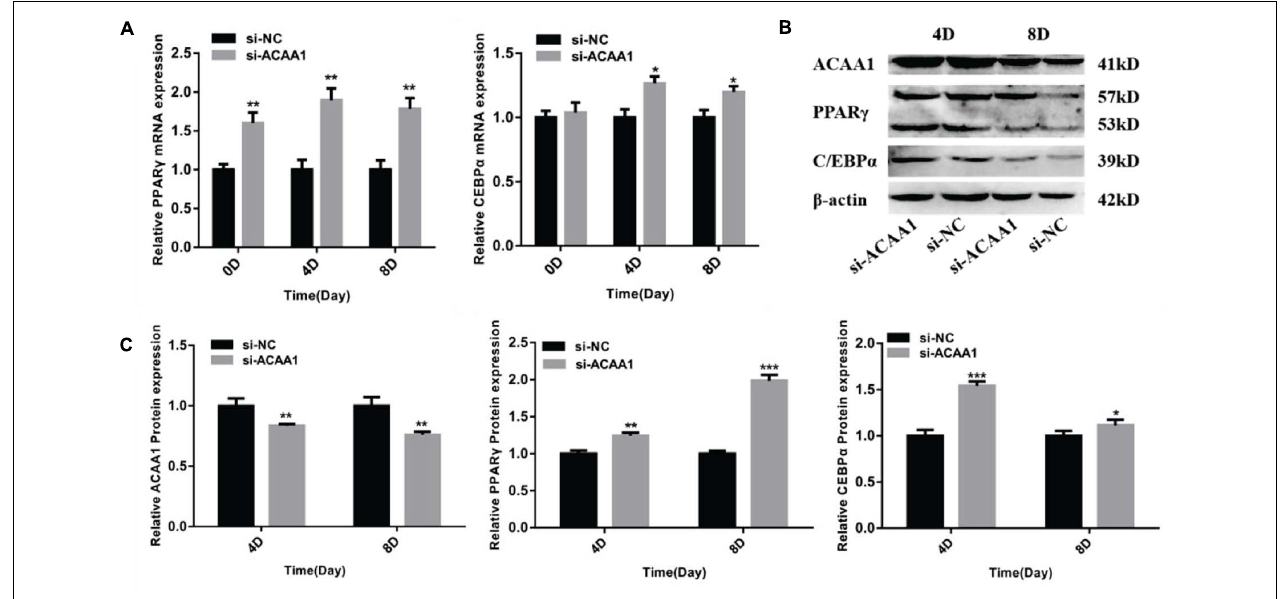
FIGURE 3 | ACAA1 knockdown regulates adipogenic marker gene expression. (A) Sheep preadipocytes were transfected with siRNA-ACAA1 or siRNA-NC and differentiated into mature adipocytes. The mRNA expression levels of adipogenic marker genes (PPAR γ and C/EBP α ) were evaluated on days 0 (after cell amalgamation), 4, and 8 of adipogenic differentiation. On day 0 of adipogenic differentiation, the mRNA expression levels of the marker genes were higher than those of the control group, but only PPAR γ reached a significant level (** p < 0.01). On days 4 and 8 of adipogenic differentiation, the mRNA expression levels of PPAR γ and C/EBP α were significantly higher than those of the control group (* p < 0.05 and ** p < 0.01). (B) Protein expression levels of ACAA1 and adipogenic marker genes on days 4 and 8 of adipogenic differentiation. Columns 1 and 2 are the siRNA-ACAA1 processing group and the siRNA-NC processing group, respectively (day 4). Columns 3 and 4 are the siRNA-ACAA1 processing group and the siRNA-NC processing group, respectively (day 8). β -actin is the internal reference gene. (C) The protein expression levels of ACAA1 and adipogenic marker genes were assessed on days 4 and 8 of adipogenic differentiation. The protein expression levels of ACAA1 were significantly lower than those of the control group (** p < 0.01), and the protein expression levels of PPAR γ and C/EBP α were significantly higher than those of the control group (* p < 0.05, ** p < 0.01, and *** p < 0.001). NC , negative